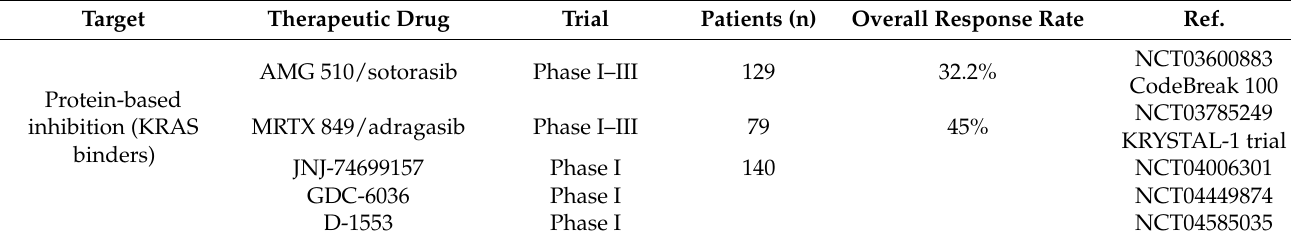
Table 4. Therapeutic strategies—Direct KRAS G12C